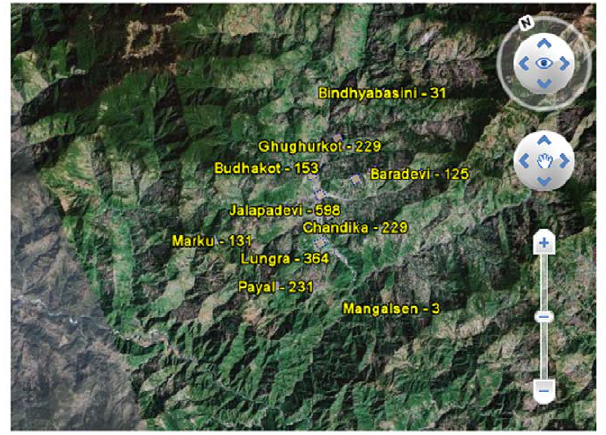
Figure 2. Screenshot of Nyaya Health mapping project. This particular image shows the number of patients from select surrounding villages over a six-month period. Using readily available GPS mapping information and data from our electronic patient database, we can map out service utilization and access to medical care. This helps in planning the geographic aspects of our community health programs.